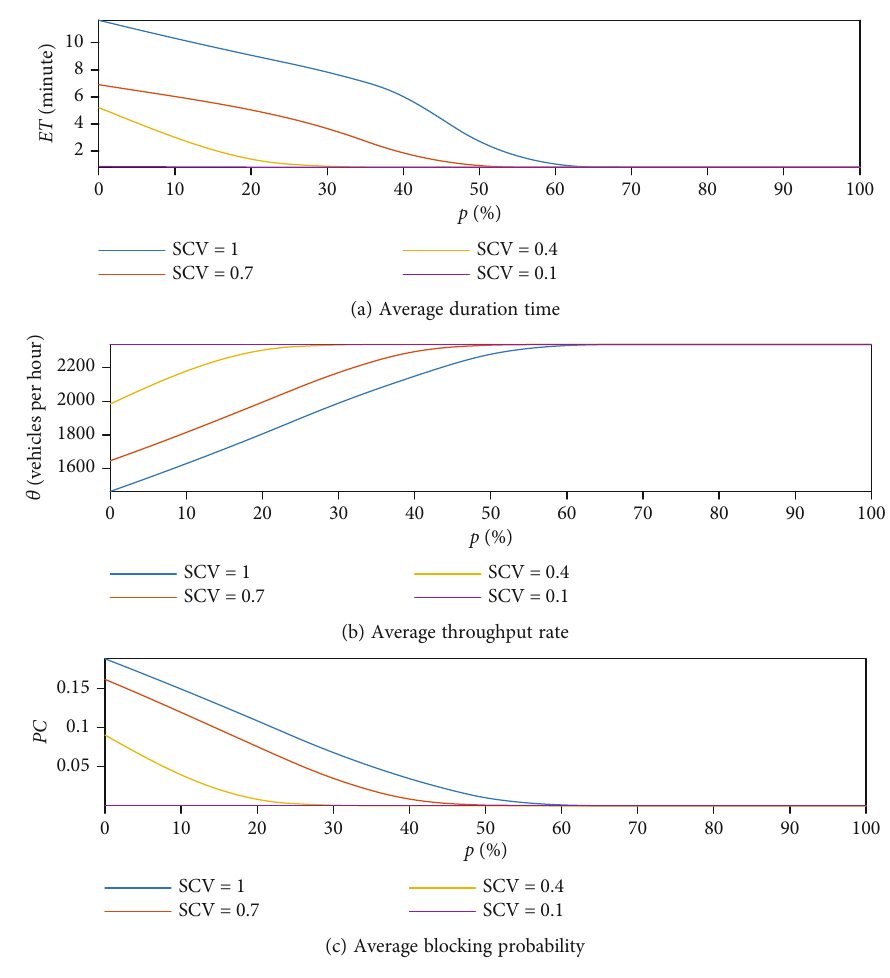
Figure 3: Average performance measures under a low tra ffi c